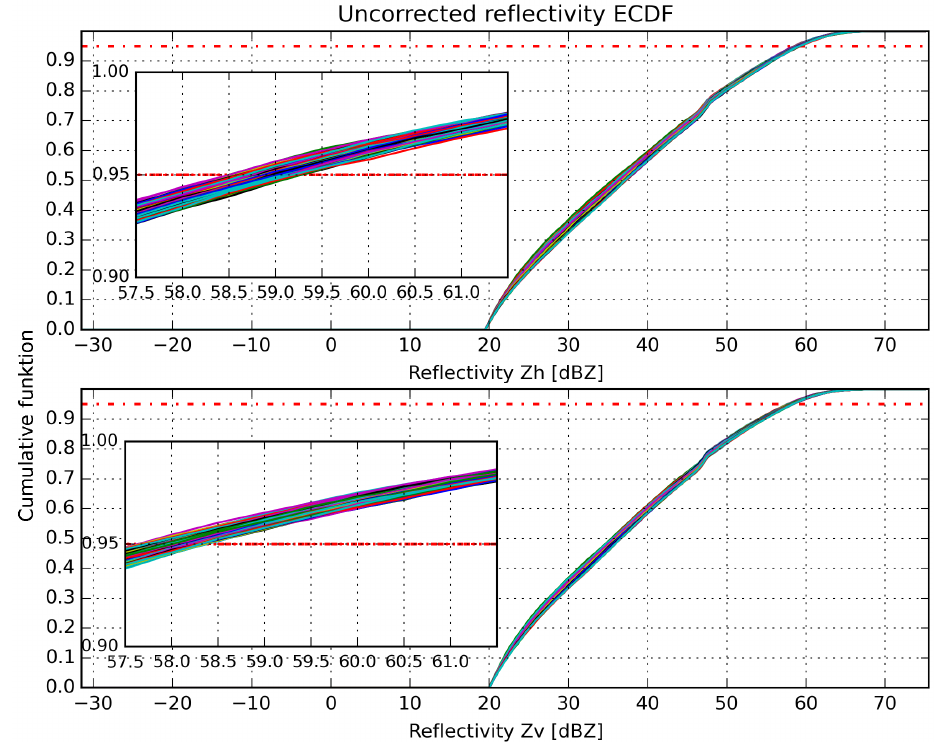
Figure 12. Z H and Z v ECDF with respective enlargements around the 95th percentile, Bric della Croce radar at elevation 0.5 ◦ , 7 October 2014. Each line represents the ECDF for a single plan position indicator